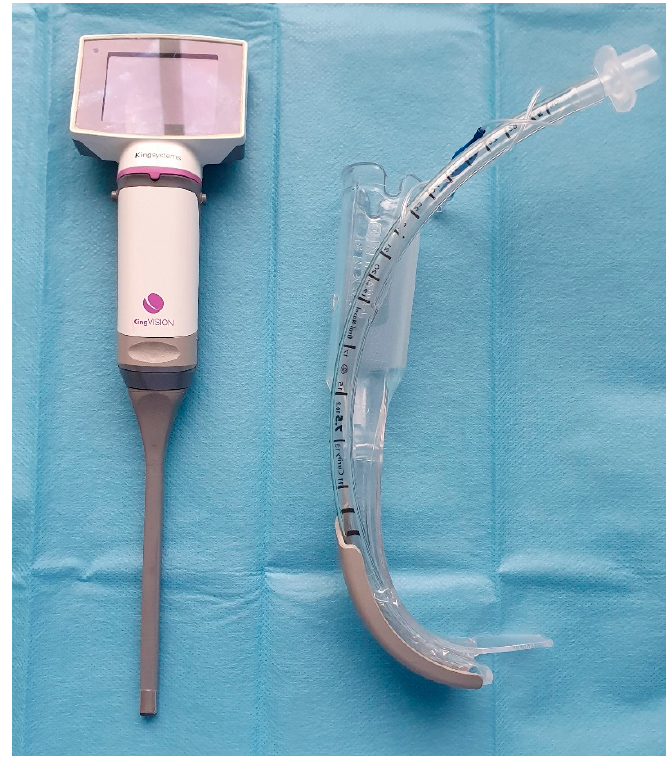
Figure 2. Channeled King Vision TM videolaryngoscope.